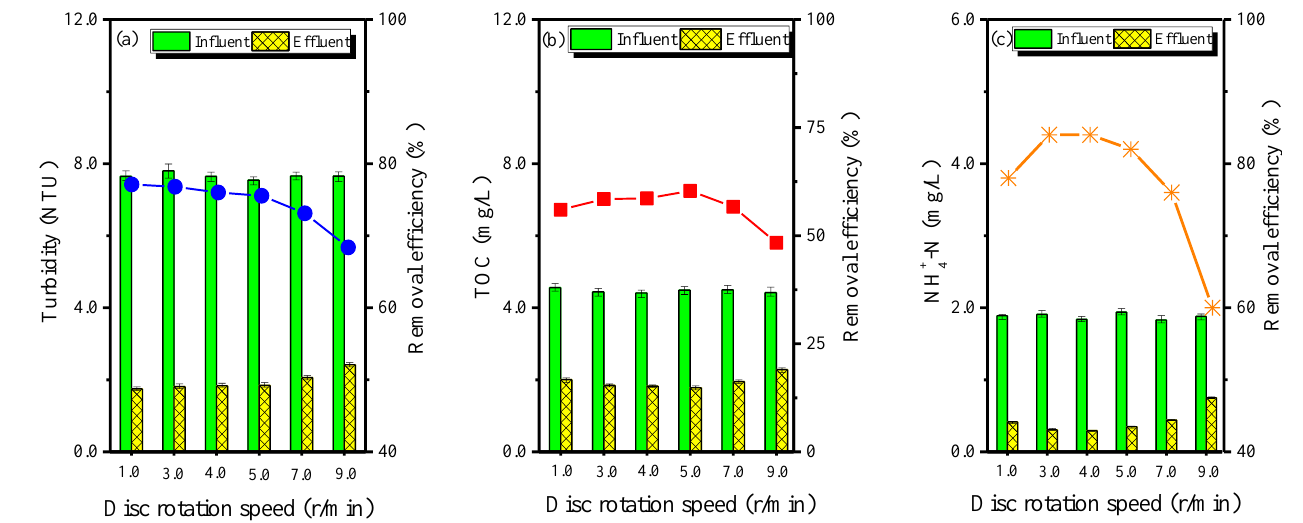
Figure 5. Effects of disc rotating speed on the removal of turbidity ( a ), TOC ( b ), and NH + treating organic and NH + -N polluted water with the modified settling tank (organic loading rate = 4 0.35 g/(m 2 ∙d) and HRT = 2